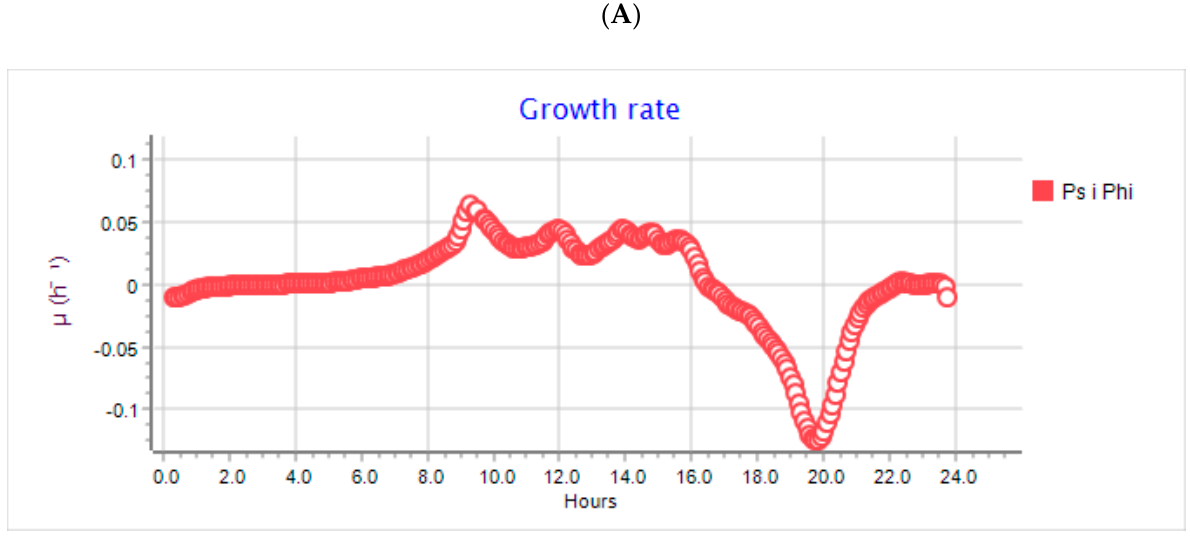
Figure 5. ( A ) OD over time for P. syringe after 48 h of incubation. Incubation with phi 6 phages, addition of the phages OD—0.2, amount of phage MOI—1; ( B ) The growth rate of P. syringe after 48 h of incubation. Incubation with phi 6 phages, addition of the phages OD—0.2, amount of phage MOI—1.